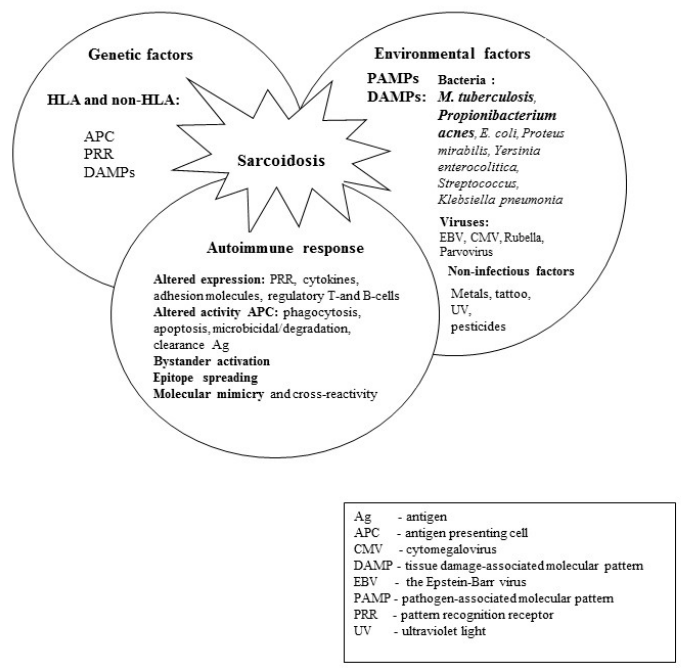
Figure 1. The etiopathogenesis of sarcoidosis.